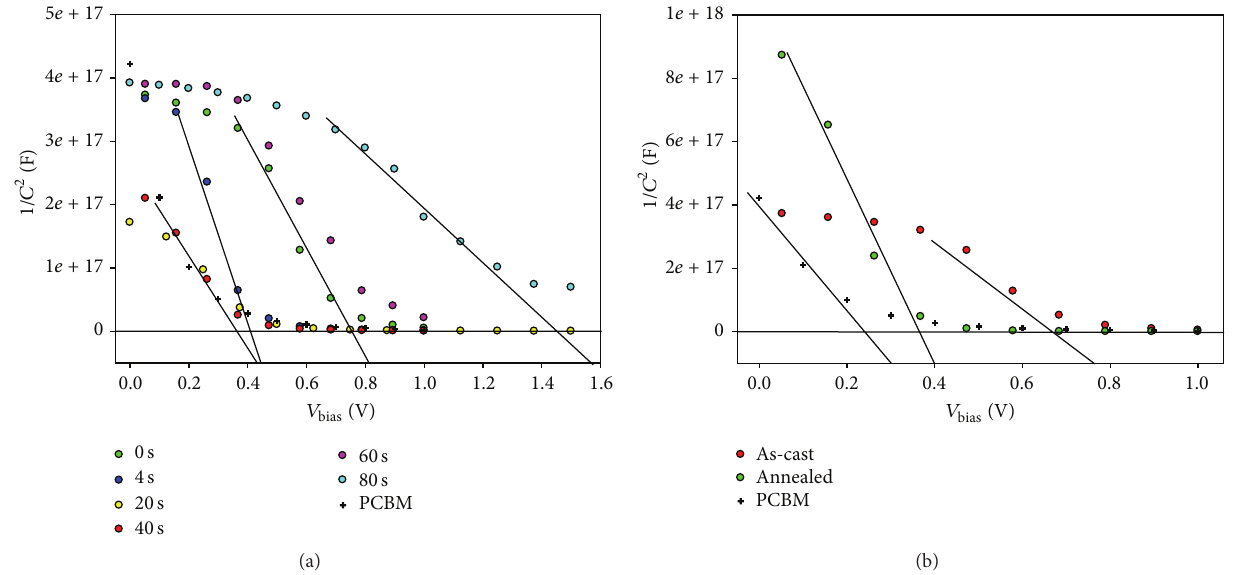
Figure 4: C-V measurements of the THF solvent (a) and thermally (b) treated devices in comparison with pure PC 60 BM layer.